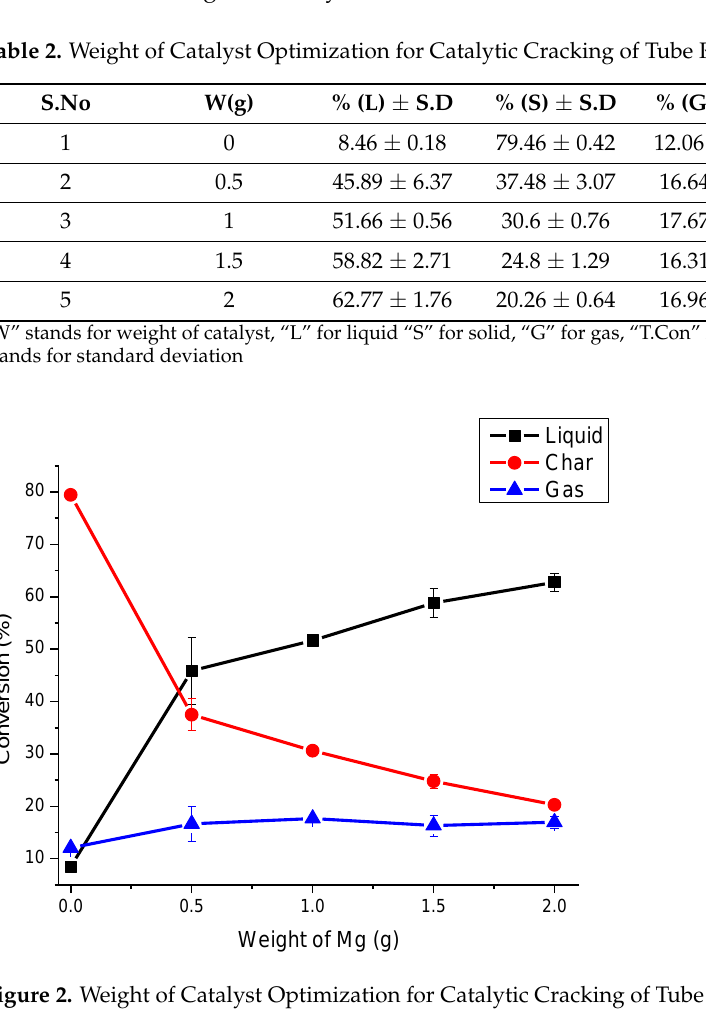
Table 2. Weight of Catalyst Optimization for Catalytic Cracking of Tube Rubber.